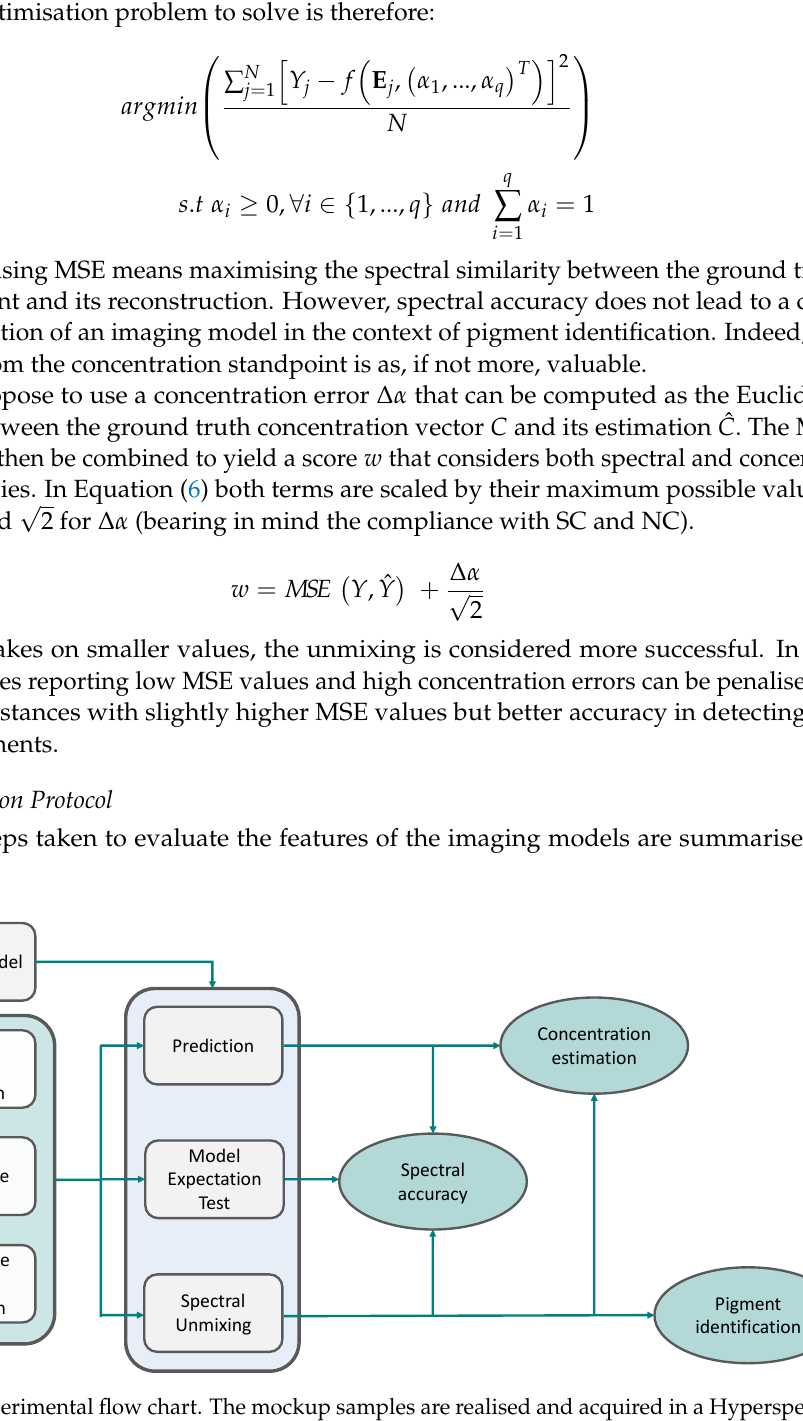
Figure 5. Experimental flow chart. The mockup samples are realised and acquired in a Hyperspectral Imaging (HSI) setup, then the reflectance factors of the patches are estimated (Section 2.2). Each imaging model is evaluated individually. Different features of the imaging models can be observed, depending on the task performed: the model expectation test allows to evaluate the spectral accuracy; the prediction task investigates spectral accuracy and concentration estimation, whereas spectral unmixing comprehends spectral accuracy, concentration estimation, and pigment